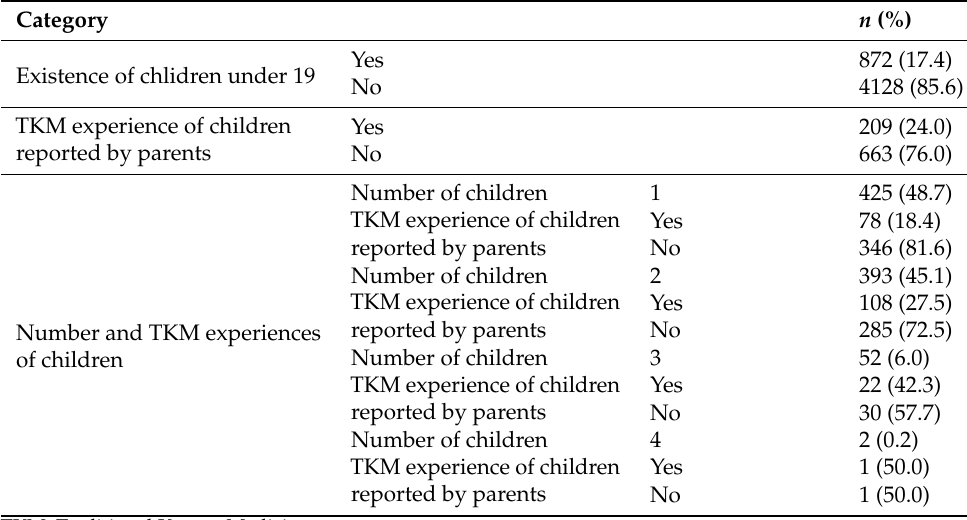
Table 1. Information and characteristics of the respondent’s